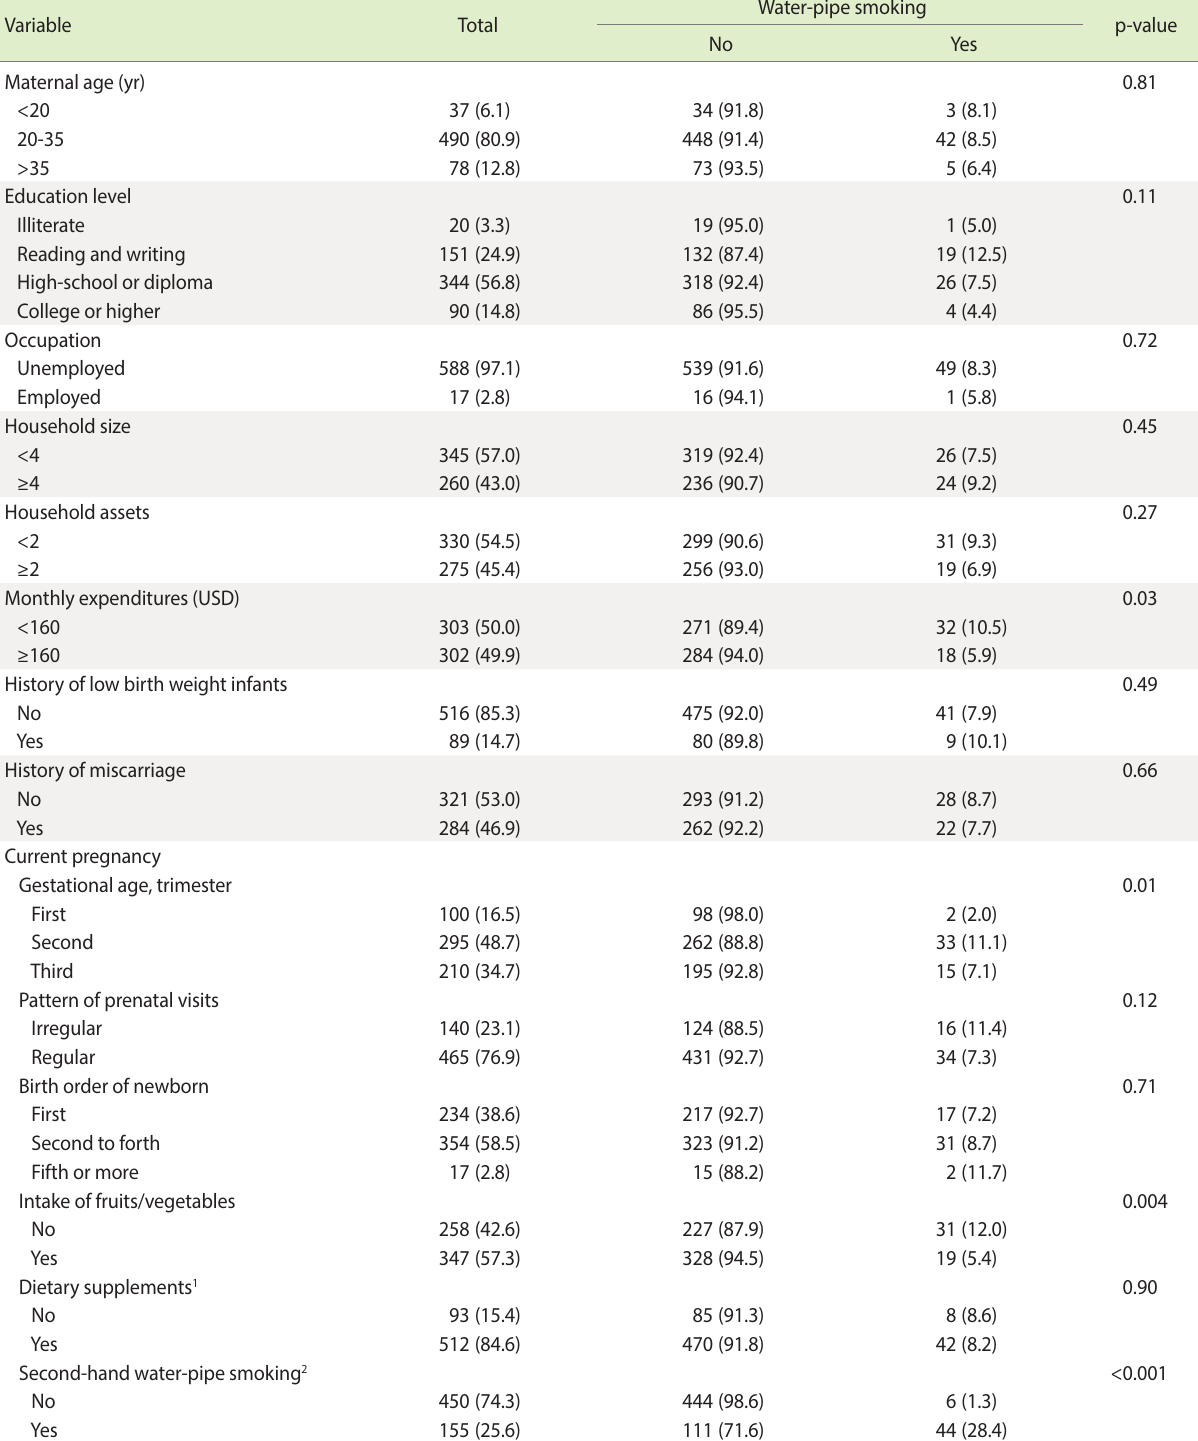
Table 1. General characteristics of pregnant women according to water-pipe smoking status in Bandar Abbas, Iran,